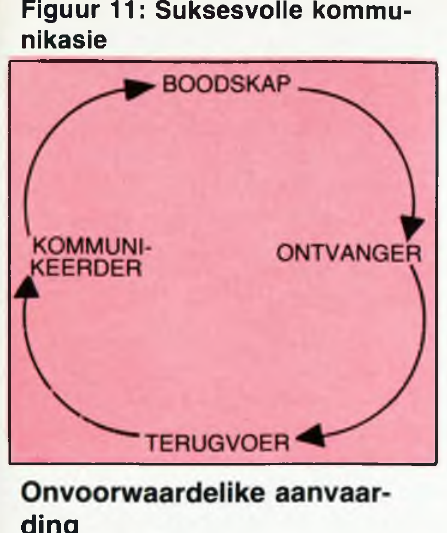
Figuur 11: Suksesvolle kommu-